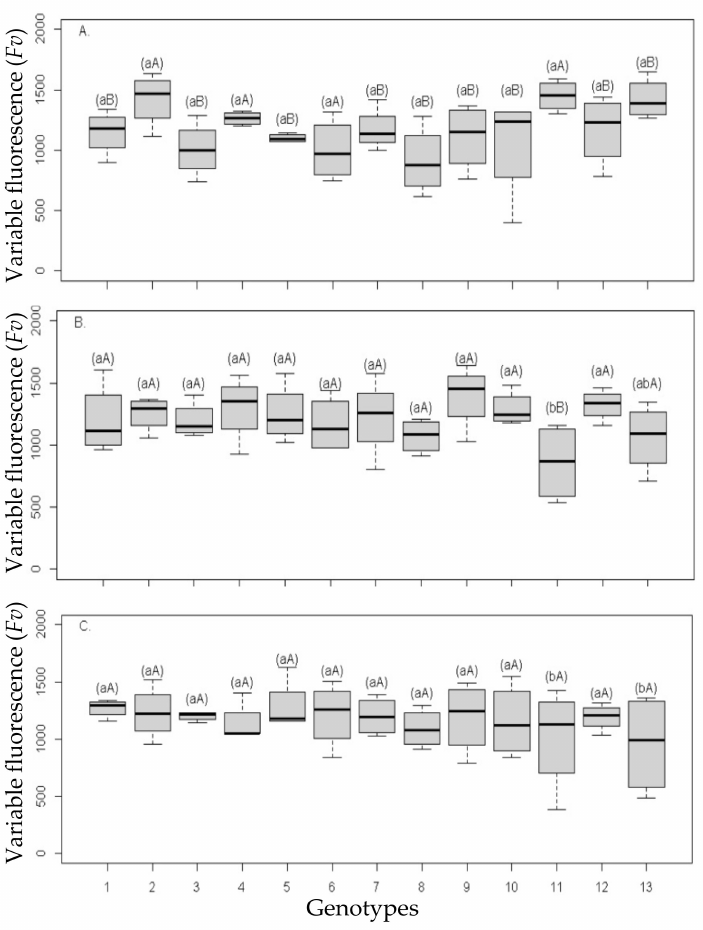
Figure 10. Boxplot relative to the average variable fluorescence (Fv) of 13 citrus rootstocks in combination with ‘Tahiti’ acid lime ( Citrus × latifolia (Yu. Tanaka) Tanaka) under irrigation with waters of 0.14 ( A ), 2.40 ( B ), and 4.80 dS m − 1 ( C ), in the second year. For identification of genotypes, see Table 1. Boxplots with the same lowercase letter do not differ statistically, according to the Tukey test between salinity levels ( p ≤ 0.05), and those with the same uppercase letter belong to the same genotype group, according to the Scott–Knott test ( p ≤